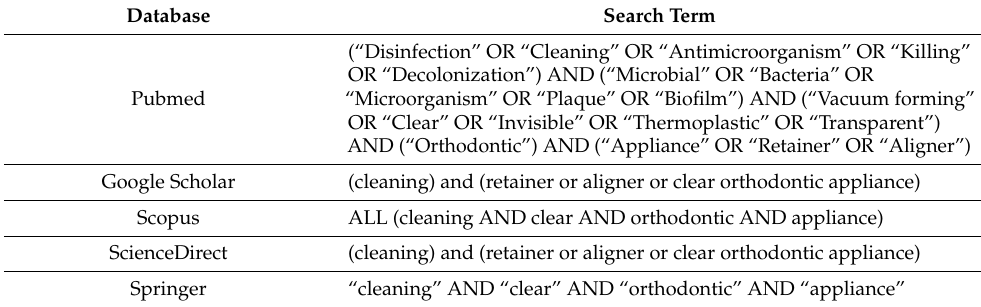
Table 1. Keywords used for each database